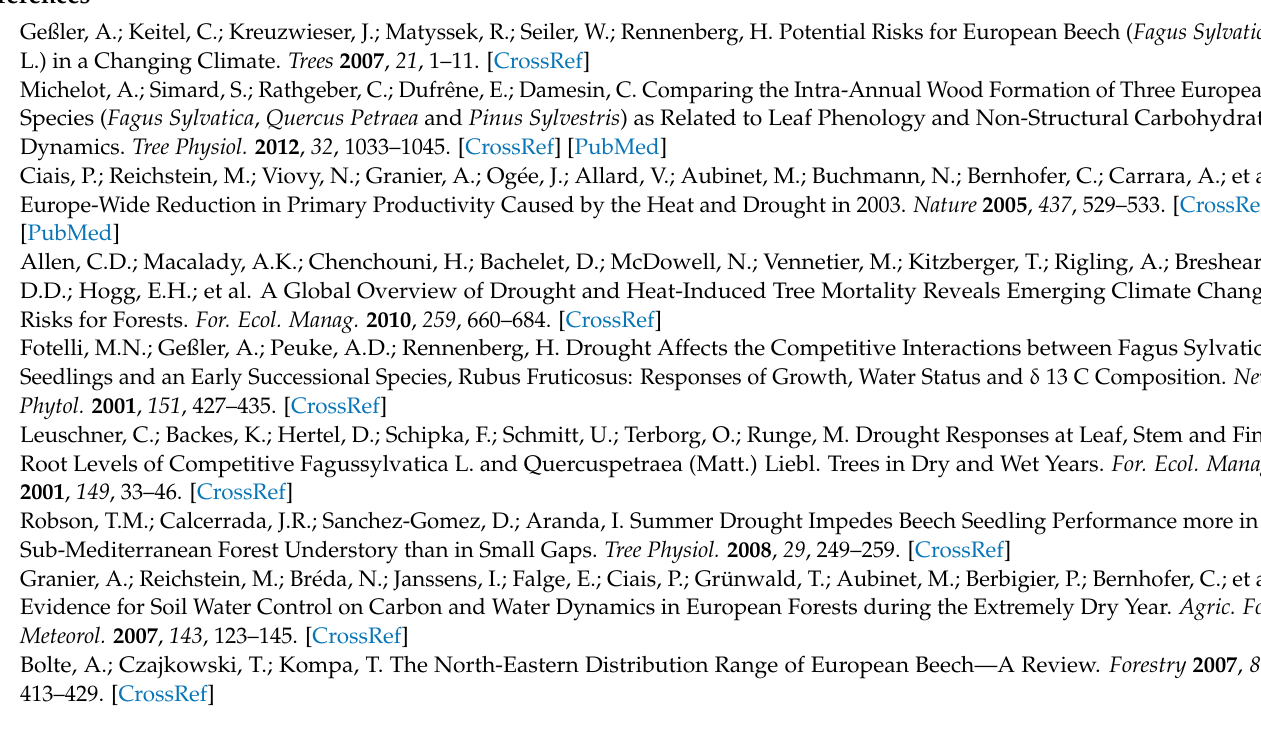
Table S1: Bioclimatic variables at the original sites of the studied populations (downloaded and extracted from www.worldclim.org, accessed on 16 December 2021); Table S2: Values of climatic variables for study populations under CSIRO MK3.6 SRES A1B for the year 2050 (downloaded and extracted from www.climond.org, last accessed: 13 February 2013). Table S3: Descriptive statistics (mean value ± standard error) of beech provenances under the applied watering